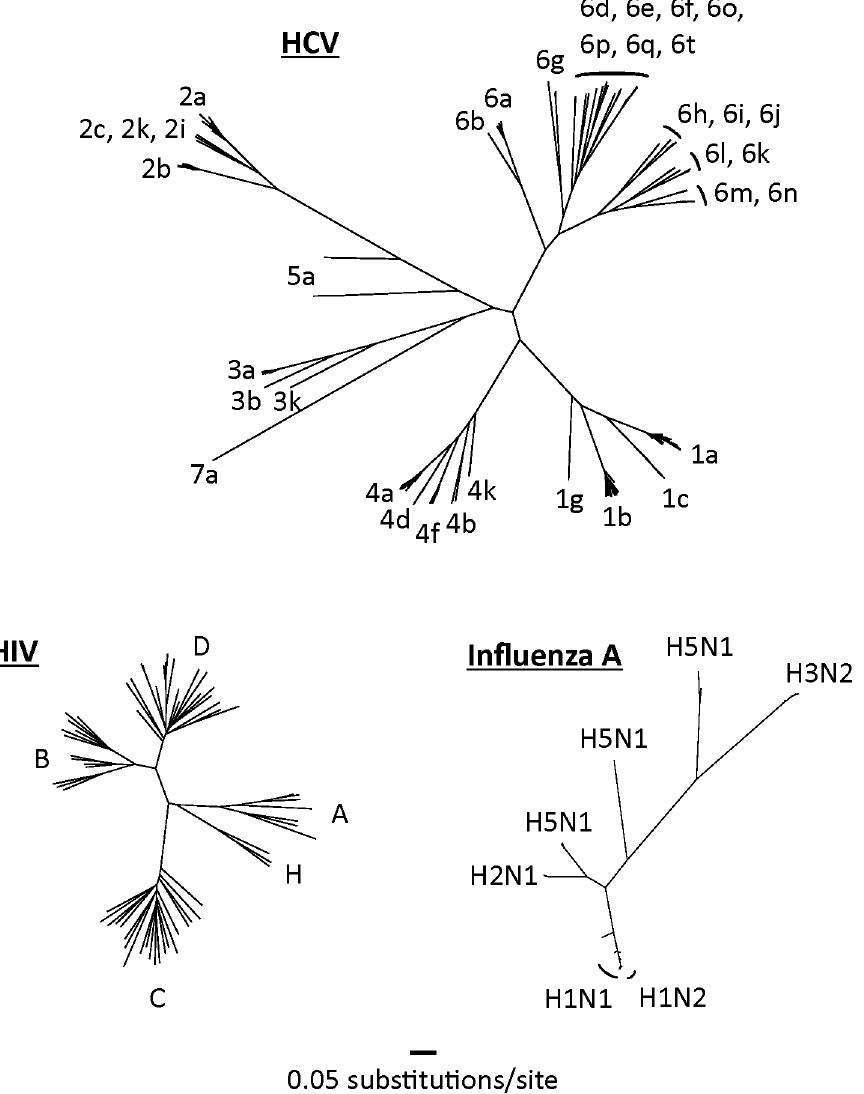
Figure 1. Complete genome trees of the hepatitis C virus, HIV-1 (M-group), and the hemagglutinin region of influenza A. Nucleotide sequences were randomly selected from their respective databases representing each of the major subtypes from each virus [17–19]. Only non- recombinant genomes were included. Maximum likelihood trees were built using GARLI (Genetic Algorithm for Rapid Likelihood Inference, available at http://www.nescent.org/). Trees have been drawn to the same scale.